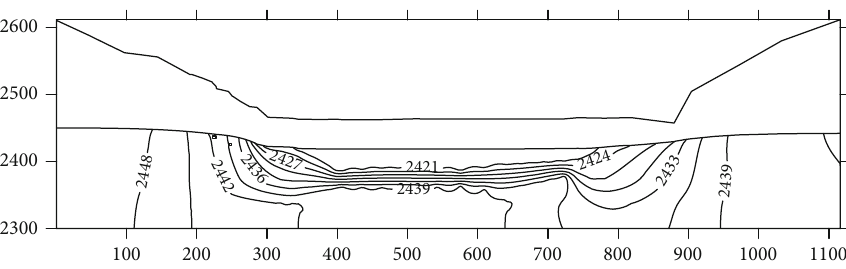
Figure 9: The isopotential distribution map of seepage fi eld about dam foundation (3-3pro fi le).